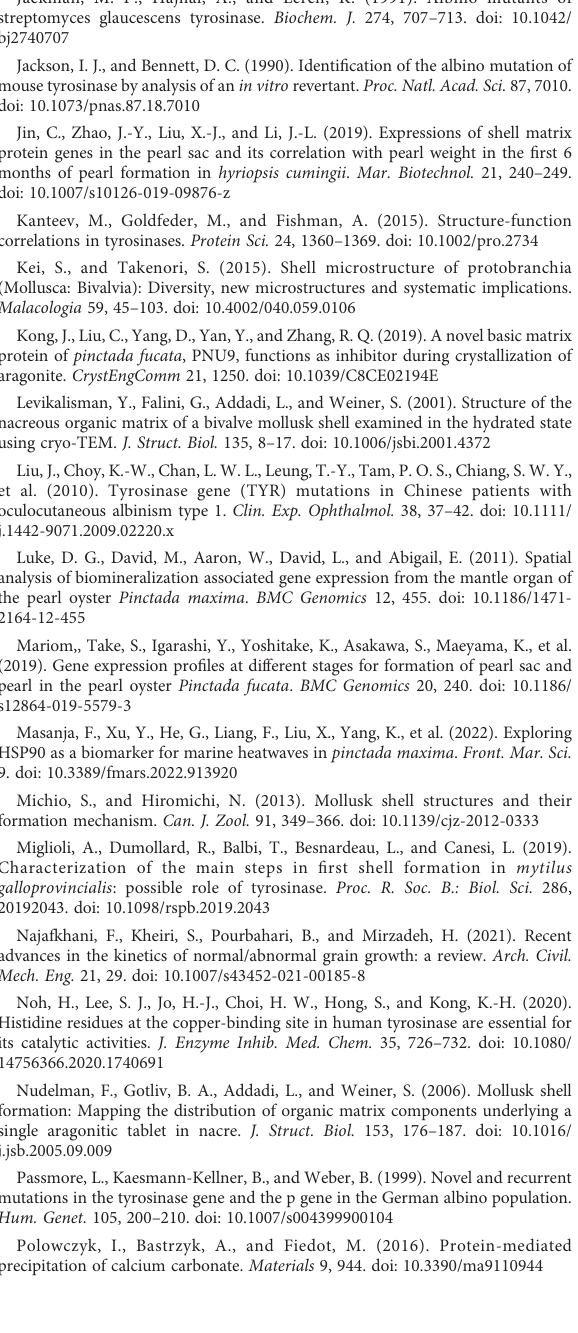
SUPPLEMENTARY FIGURE 2 Phylogenetic analysis of mollusk bivalve tyrosinase. P. f. martensii,